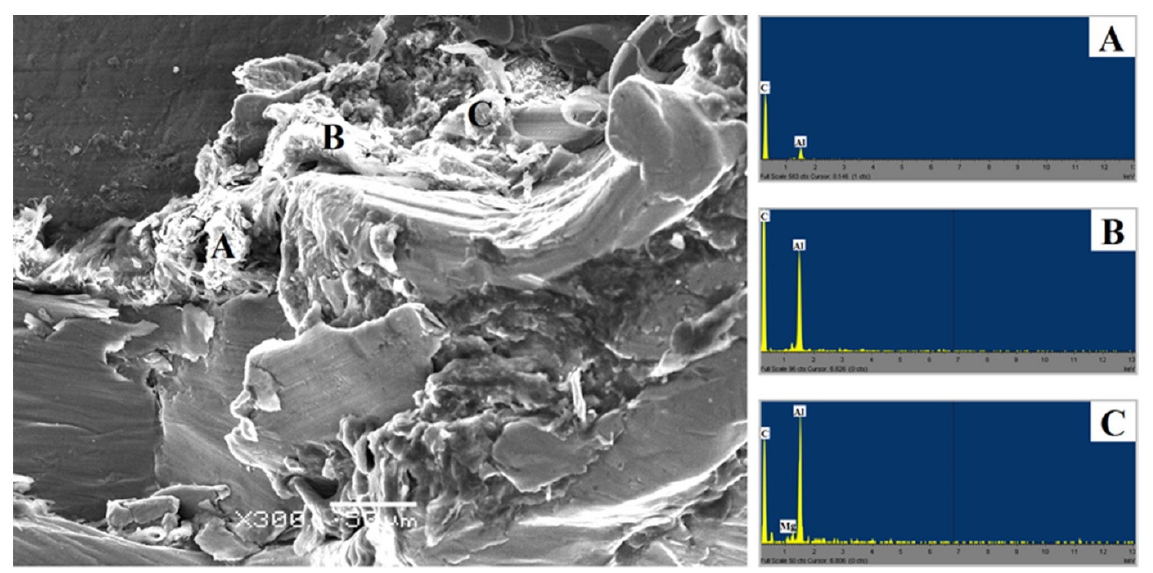
Figure 6. FE-SEM image with related EDS spectra from the surface of transverse tensile dissimilar Al–HDPE FSW failed joint at HDPE matrix (point A ), and AA5059–HDPE interface (points B and C ). Reprinted with permission from Ref. [73]. 2014, F. Khodabakhshi et al.The most